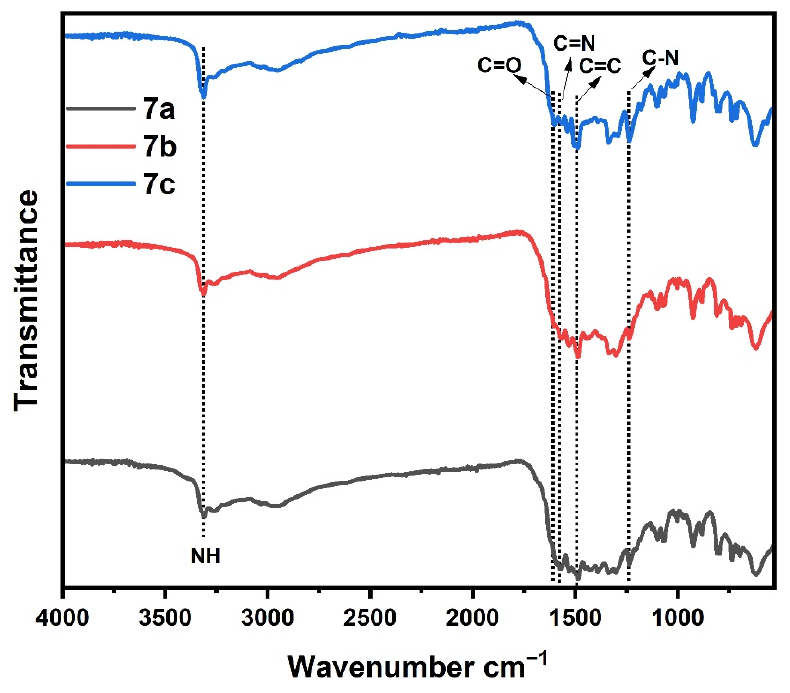
Figure 1. FT-IR spectrum of samples (5a-c).